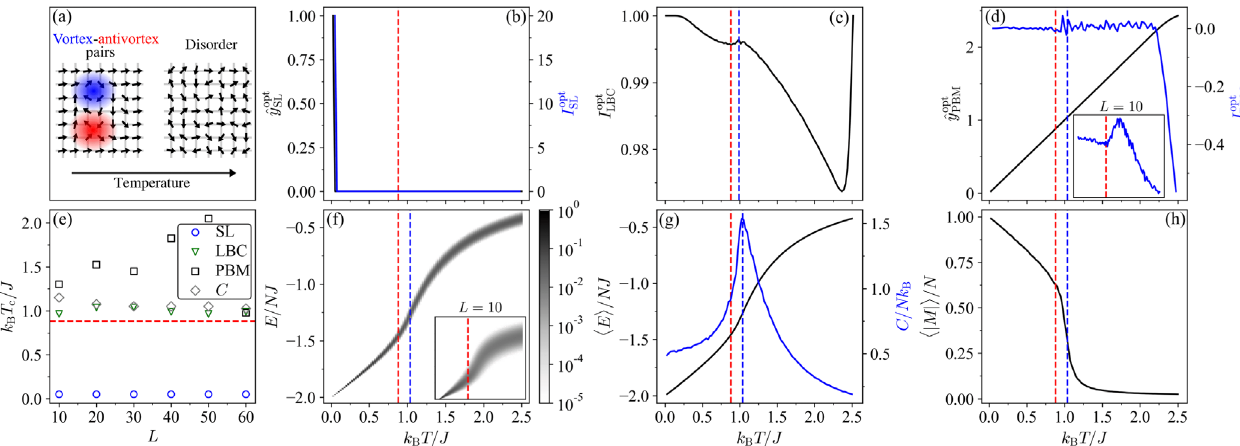
T=J , where p 1 ¼ 0 . 025 , FIG. 5. Results for the XY model ( L ¼ 60 ) with the dimensionless temperature as a tuning parameter p ¼ k B 2 . 5 , and Δ p ¼ 0 . 025 . In SL, the data obtained at p 1 and l K . The BKT transition p 1 and p K constitute our training set, i.e., r I ¼ K ¼ II ¼ T =J ≈ 0 . 8935 [92] is highlighted by a red dashed line. The blue dashed line highlights the estimated critical temperature temperature k B c in SL (black line) and the using LBC. (a) Illustration of the BKT phase transition in the XY model. (b) Mean optimal prediction ˆ y opt SL corresponding indicator I opt (blue line). (c) Optimal indicator of LBC, I opt (black line). The blue dashed line highlights the predicted SL LBC in PBM (black line) and the corresponding indicator I opt (blue line). critical temperature of LBC. (d) Mean optimal prediction ˆ y opt PBM PBM The inset shows the optimal indicator signal of PBM for L ¼ 10 , which exhibits a peak near the location of the maximum in the heat capacity. (e) Estimated critical temperature based on I opt (SL), I opt (LBC), I opt (PBM), and heat capacity ( C ) as a function of the lattice PBM SL LBC size L . The estimated critical temperature of the heat capacity corresponds to the location of its maximum. (f) Probability distributions governing the input data (here, the energy) as a function of the tuning parameter, where the color scale denotes the probability. The inset shows the probability distributions for L ¼ 10 . (g) Average energy per site (black line) and associated heat capacity (blue line) as a function of the temperature, where N ¼ L 2 . (h) Average magnetization per site as a function of the